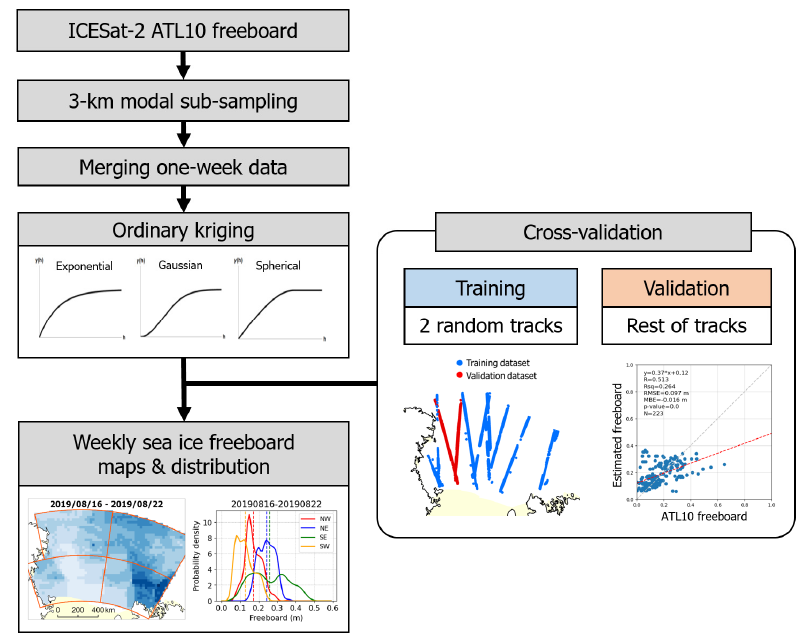
Figure 4. Flowchart of the geostatistical kriging modelling and mapping.